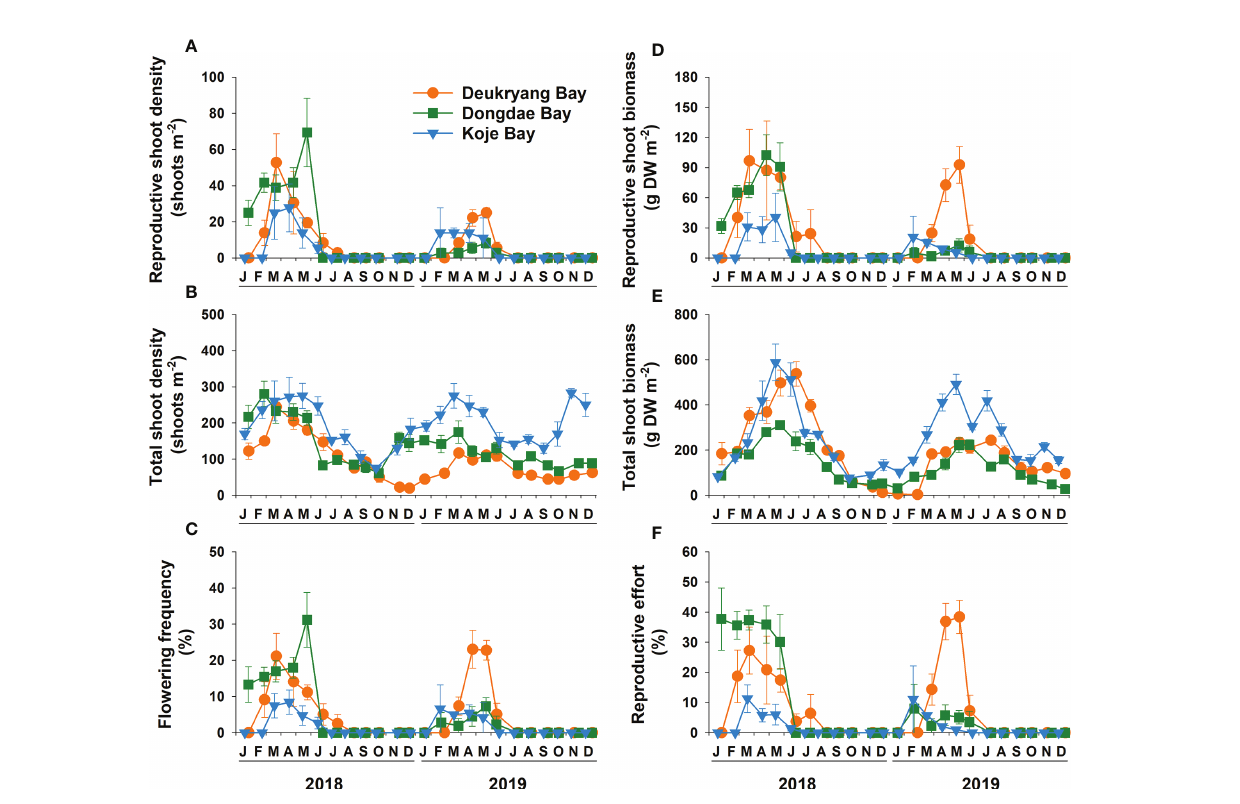
FIGURE 4 | Zostera marina . Seasonal changes in reproductive (A) and total (B) shoot density, fl owering frequency (C) , reproductive (D) and total (E) shoot biomass, and reproductive effort (F) in Deukryang Bay, Dongdae Bay, and Koje Bay on the southern coast of Korea from January 2018 to November 2019. Values are means ± SE (n =